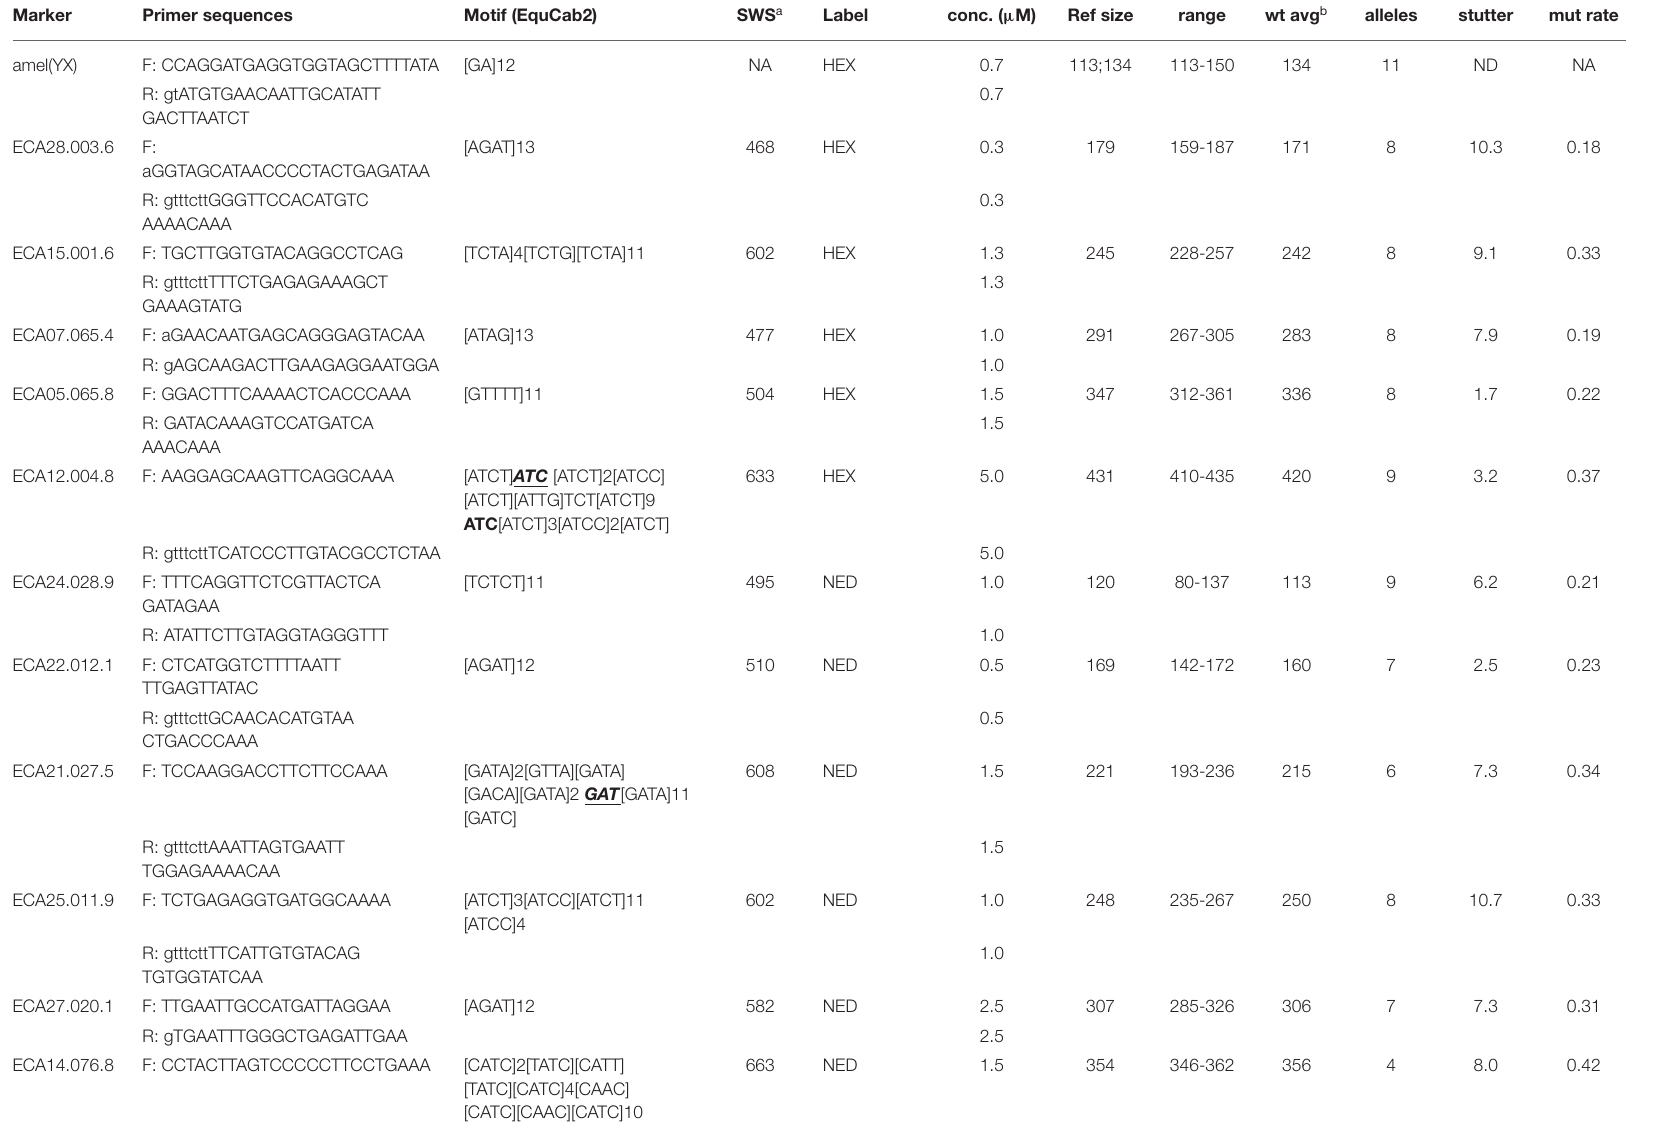
TABLE 1 | Marker primers, observed data, and mutation rate